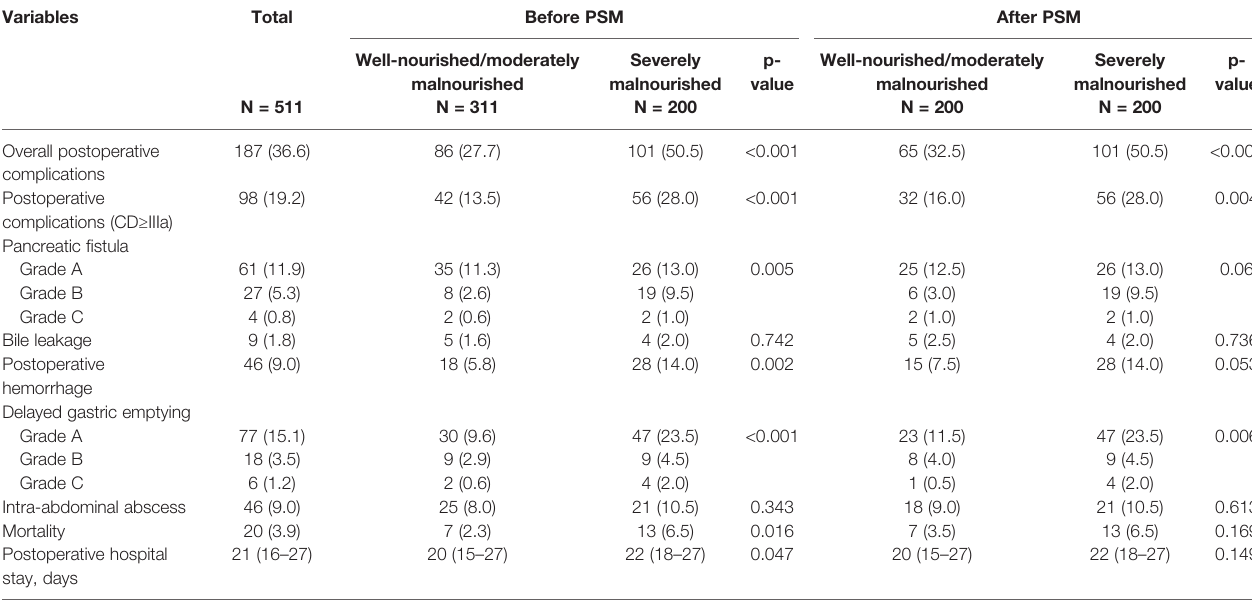
TABLE 3 | The relationships between preoperative nutritional status and postoperative short outcomes in 511 patients who underwent pancreatoduodenectomy for ampullary carcinoma after PSM.